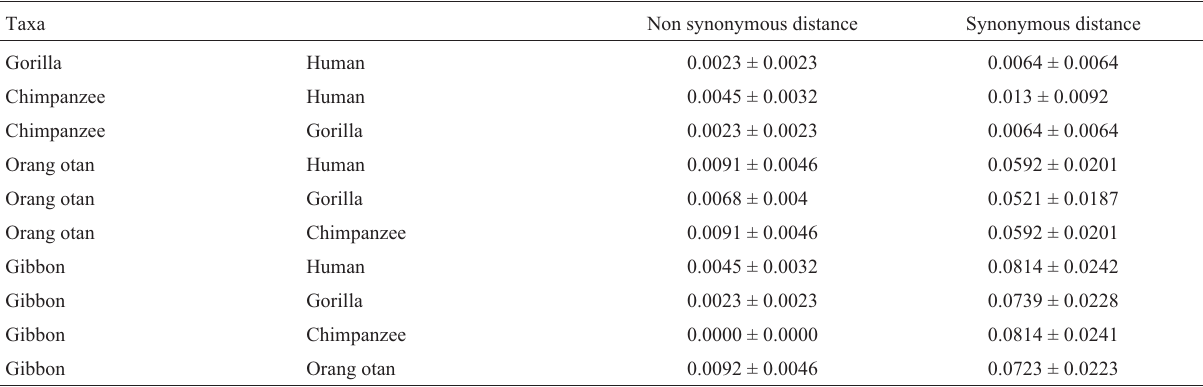
Table 2 - Estimation of non synonymous and synonymous rate by the method of Yang & Nielsen (2000